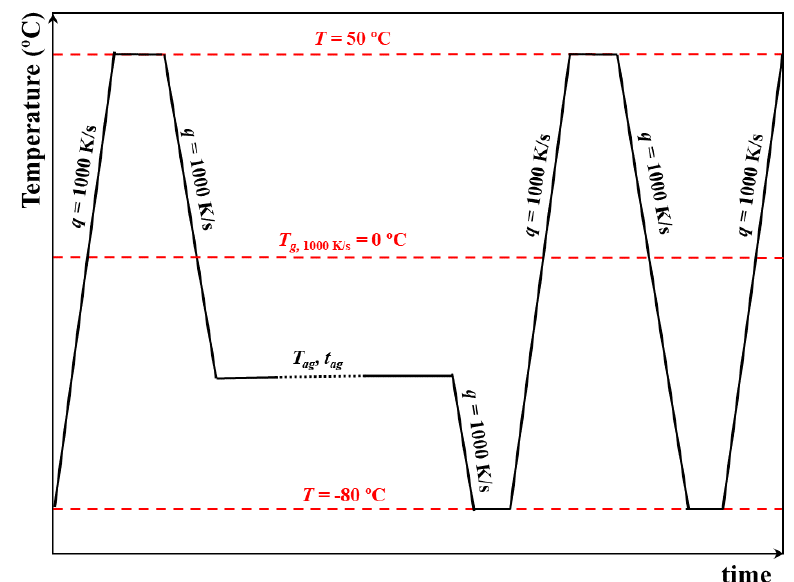
Figure 2. Thermal protocol employed to study physical aging in